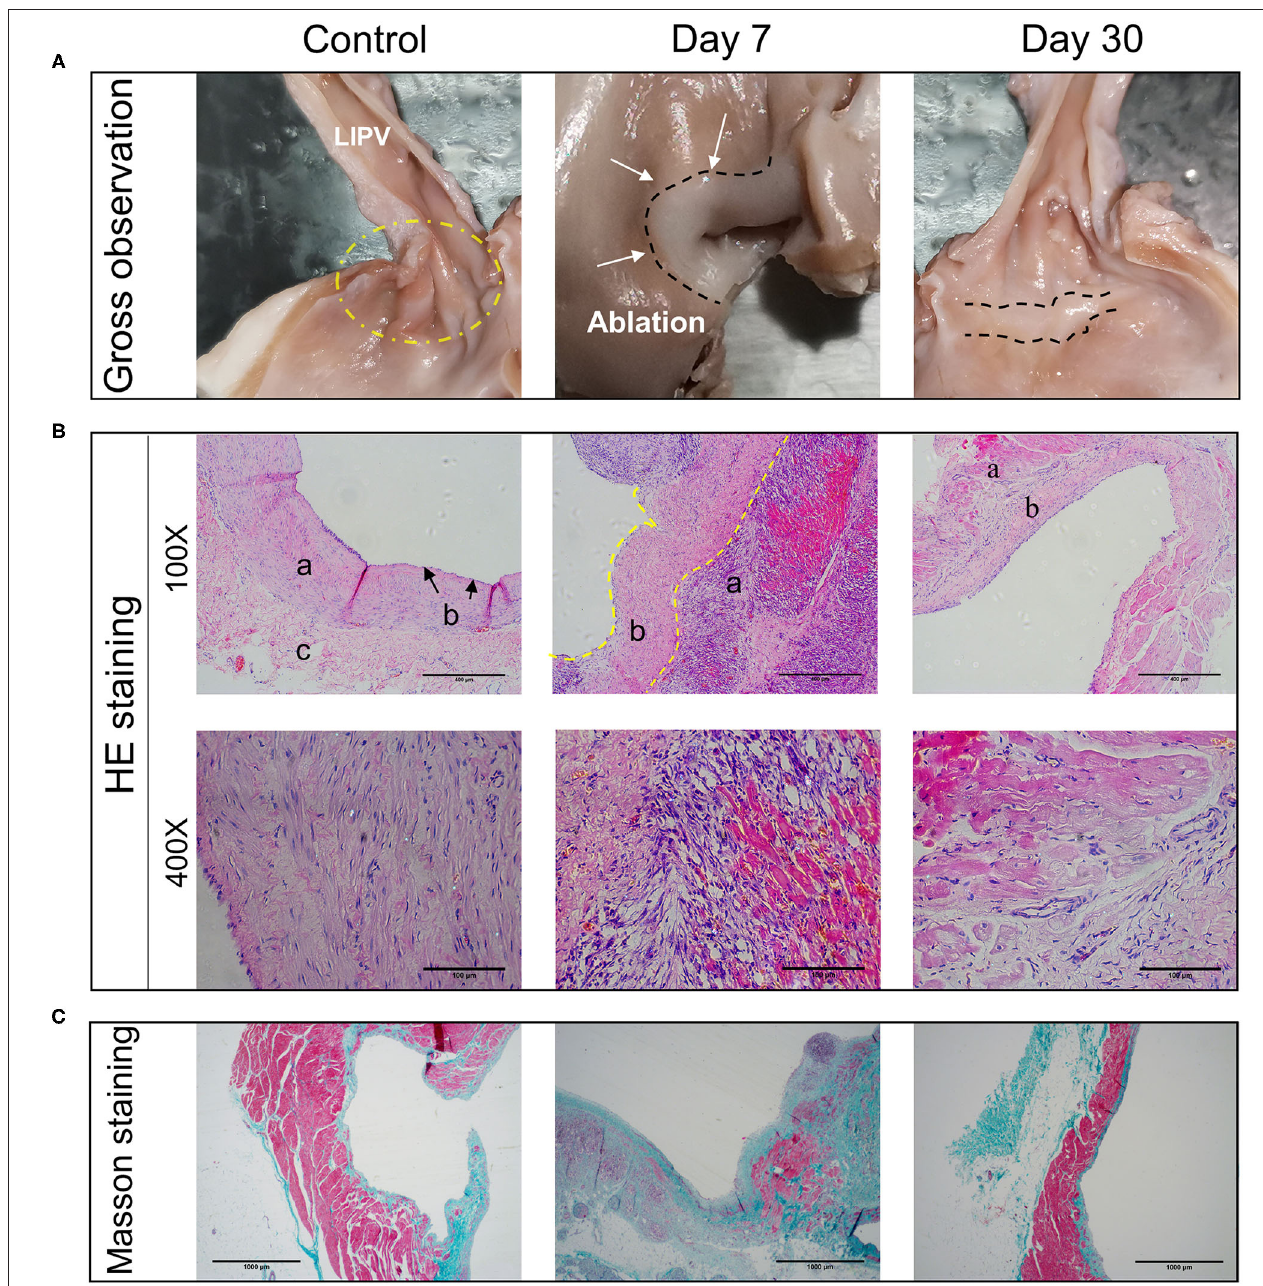
FIGURE 3 | Pathological changes of myocardial tissues after PFA ablation. (A) Gross observation of the left superior pulmonary vein ablation site. In the control group, lesion areas were not seen. The 7- and 30-day groups (group A and B) show a clear ablation zone. (B) HE staining of ablation sites at 100X and 400X. a indicates myocardial tissue. b represents intimal layer (endothelium, fibroblasts and connective tissue). c is marked with adventitia. (C) Masson staining of ablation sites (40X). Control group, days 7 and 30 from left to right.